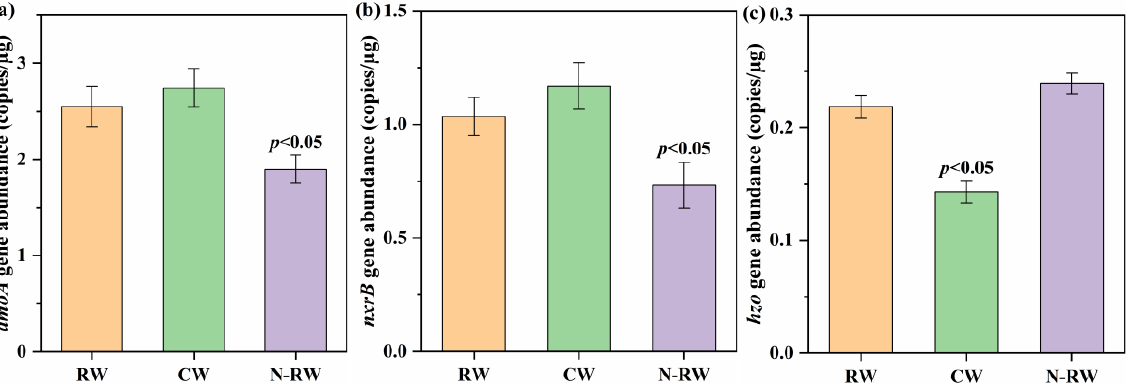
Figure 7. ( a ) amoA gene abundance; ( b ) nxrB gene abundance; ( c ) hzo gene abundance in three groups of wetland systems. Note: p < 0.05 compared to RW.